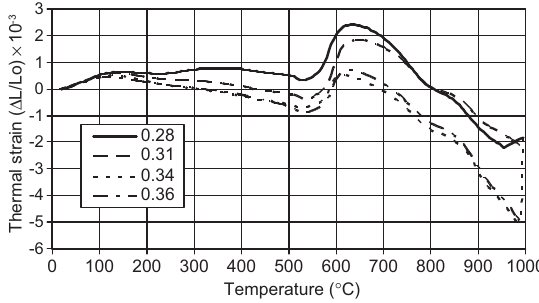
Figure 6 Thermal strain ratios of SCLC with tuff vs.